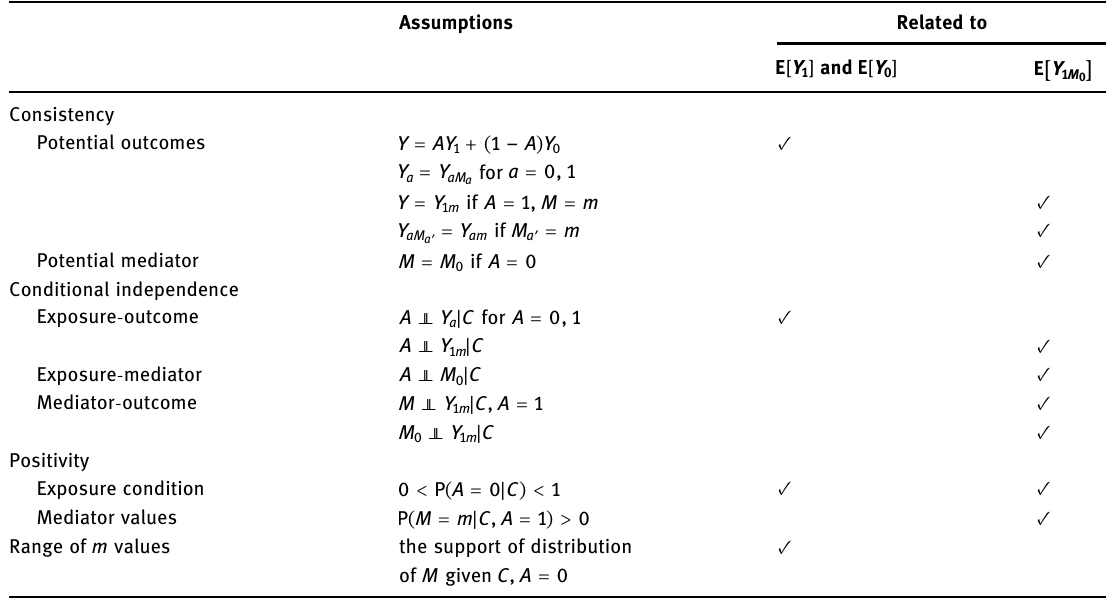
Table 9: Identifying assumptions for NDE 0 and NIE 1 Assumptions Related